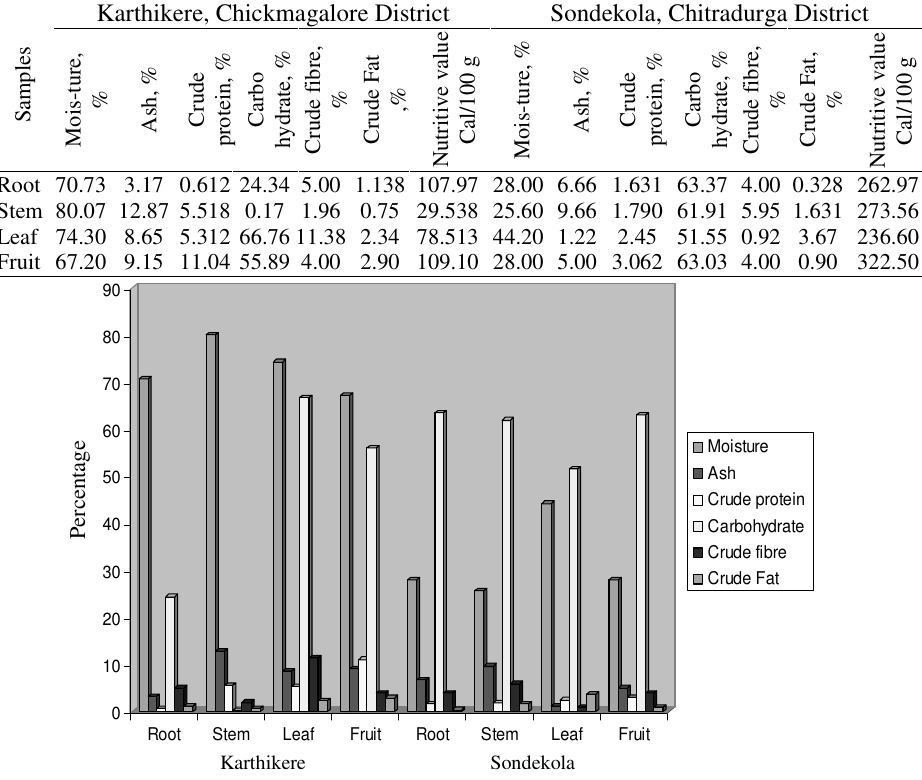
Figure 4. Variation of nutritional components (in percent) of the root, steam, leaf and fruit samples of Withania somnifera ( Linn.) Dunal at Karthikere and Sondekola of Karnataka, India. The plant parts of Sondekola recorded lowest moisture values. The maximum values of 44.20% and minimum values of 25.60% were recorded in the leaf and stem samples of Sondekola. The ash percentage of Karthikere varied between 3.17% and 12.87%. The maximum values were recorded in the stem samples and minimum values recorded in the root samples. At Sondekola, the plant parts recorded minimum and maximum values of 1.22% and 9.66% in the leaf and stem samples respectively. The percentage of crude protein values varied between 0.61% and 11.04%; 1.63% and 3.06% from the Karthikere and Sondekola samples respectively. It is interesting to note that the highest percentage of crude protein was recorded in the fruit samples of both Karthikere and Sondekola samples. The percentage of carbohydrate values was highest in the leaf samples of Karthikere and the root samples of Sondekola. The percentage carbohydrate values varied between 0.17% and